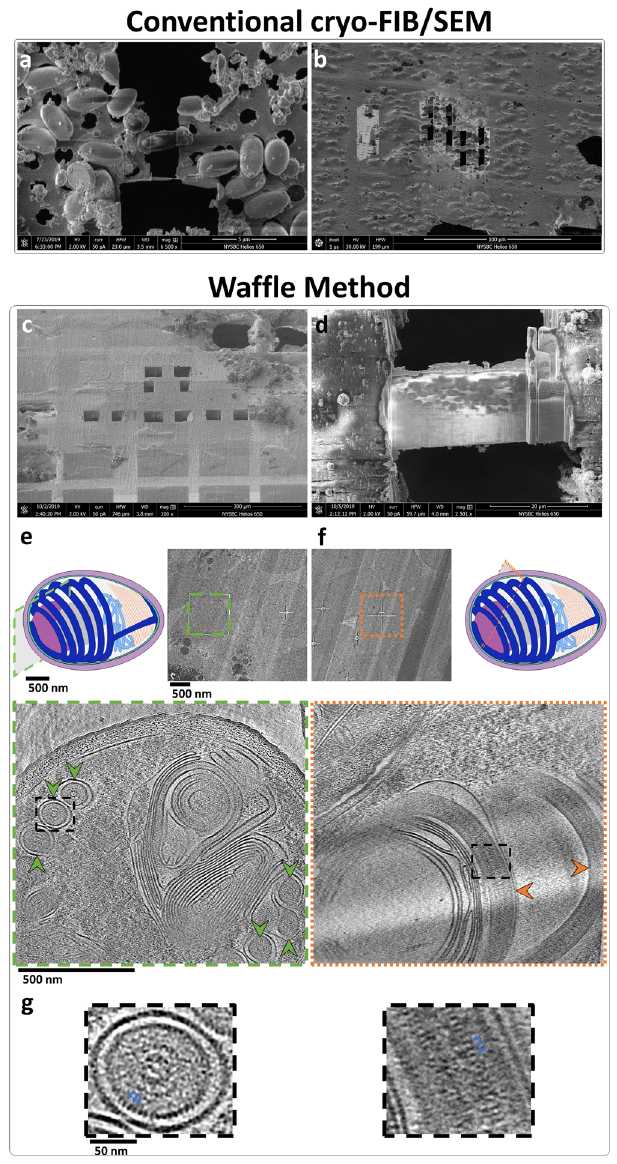
solves the preferred orientation problem inherent with the specimen and the object of interest in the spores, the polar tube. several orientations, allowing for the full 3D structure of the polar tube to be visualized. The low-mag images in Fig. 3e, f show TEM images of the spores, including an oblique-view in Fig. 3f which is not present in conventionally prepared lamellae (Fig. 3a). The schematic diagrams of the spores in Fig. 3e, f depict cross-sections of approximate locations where tomograms were collected. The bottom images in Fig. 3e, f show slice-throughs of 3D tomograms collected at these two locations. Roughly orthogonal orientations of the polar tubes are present in these tomograms (Supplemen- tary Movie 3), uniquely allowing for nanometer-level features of the polar tube to be visualized. Figure 3g shows 4x magni fi ed views of the square dashed black line inset in the bottom images of Fig. 3e, f. These magni fi ed views show an axial view and a side view of polar tubes with bumps that are about 2.5 nm in dimension clearly visible on the second cylindrical layer of the tube.